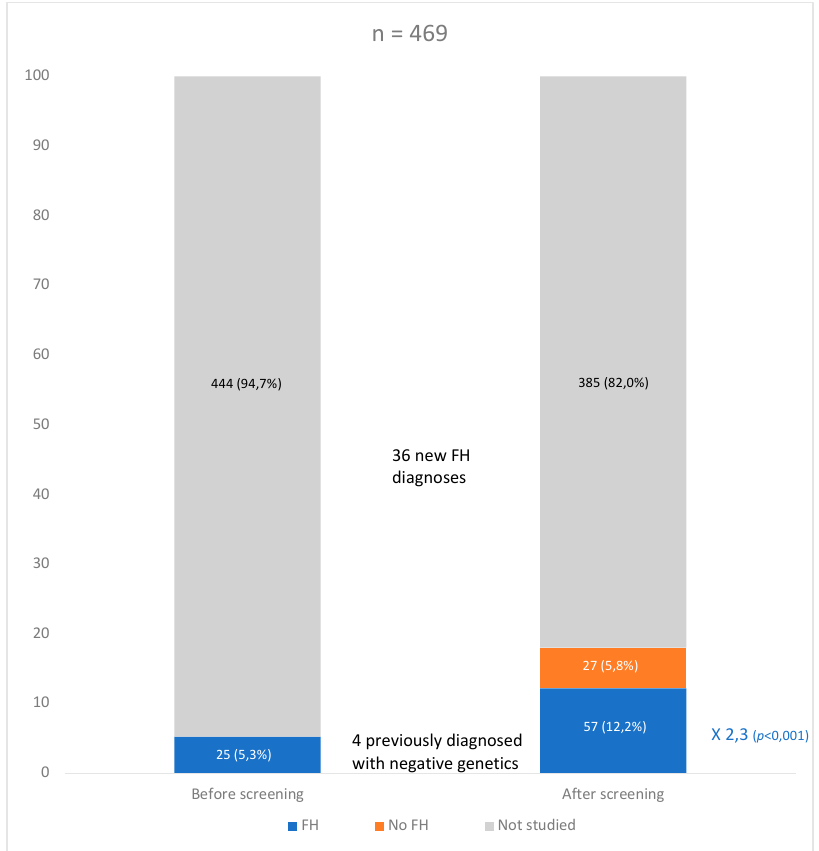
Figure 2. The positive and negative rates in the genetic study. Bar graph presenting the percentages of genetic diagnosis according to DLCN criteria. DLCN: Dutch Lipid Clinic Network.